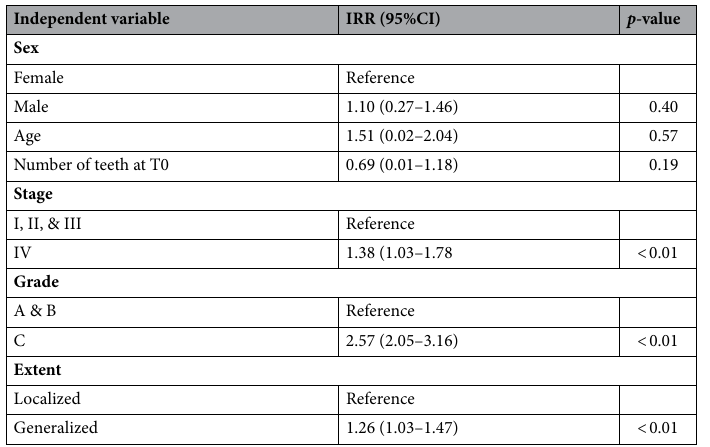
Table 5. Results of multivariate analysis (negative binomial regression) of number of extraced teeth during APT + SPT. Multivariate analysis (negative binomial regression) of the number of extracted teeth due to periodontitis per patient during APT + SPT; analysis was corrected for the period of follow-up. APT active periodontal therapy; SPT supportive periodontal therapy; IRR incidence rate ratio; CI confidence interval; T0 start of APT.